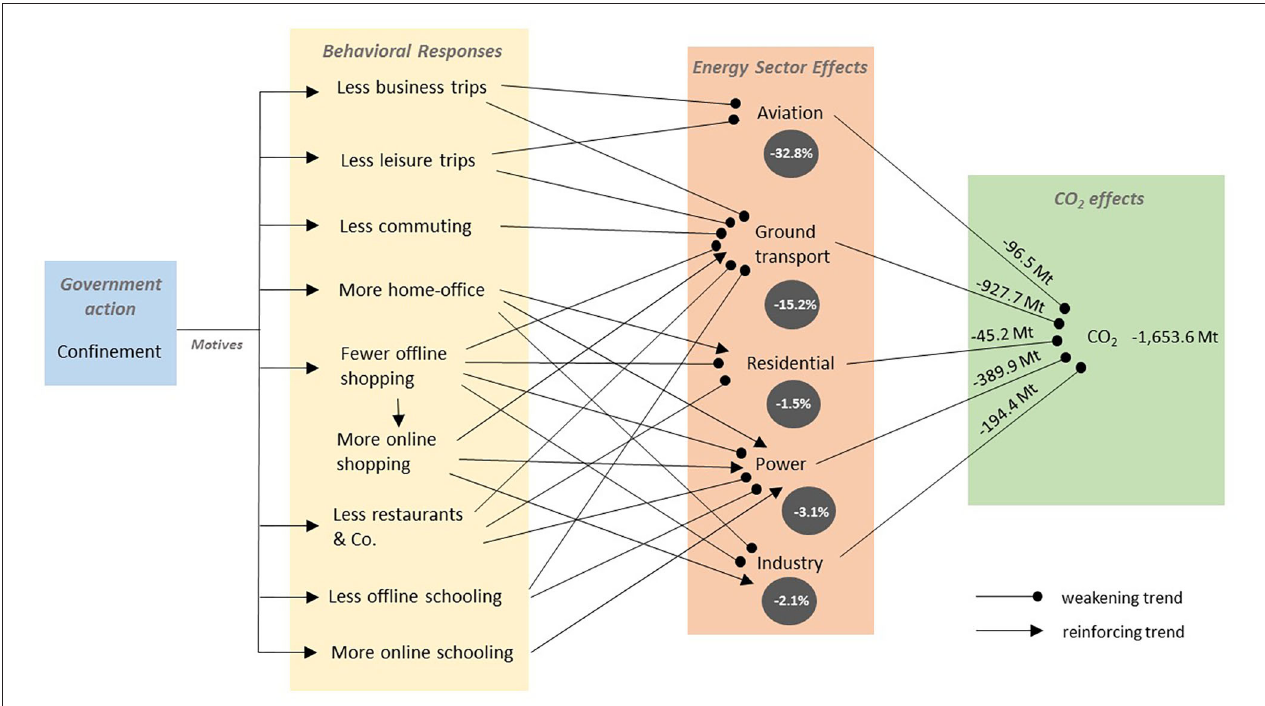
FIGURE 5 | Behavioral responses to government induced confinements, energy sector and global CO 2 effects. Source: own graph, data taken form Liu et al. (2020a).